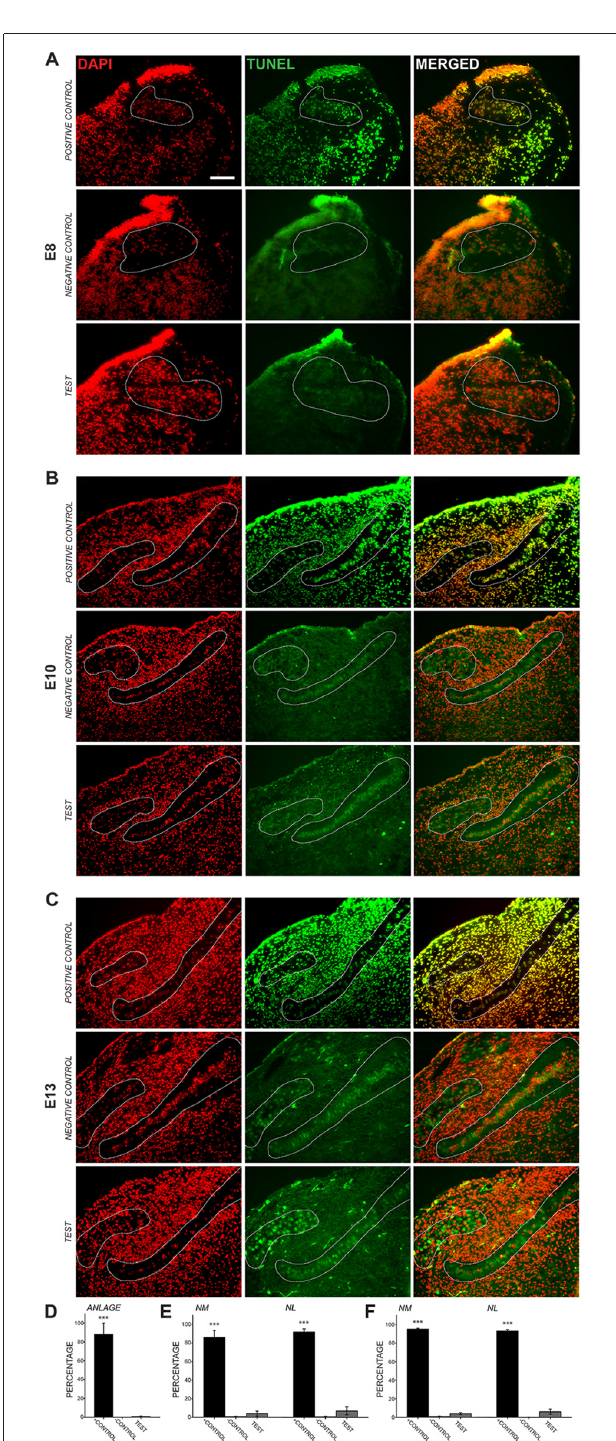
FIGURE 2 | Transferase dUTP nick end labeling (TUNEL) assessment of development cell death. 4 (cid:48) ,6-diamidino-2-phenylindole (DAPI) labels all cell nuclei, while TUNEL labels nicked DNA characteristically seen during apoptosis. (A) At E8, NM and NL have not completely separated from one another and are found in the auditory anlage (dashed lines). Positive control sections show nearly perfect alignment of DAPI-labeled cell nuclei